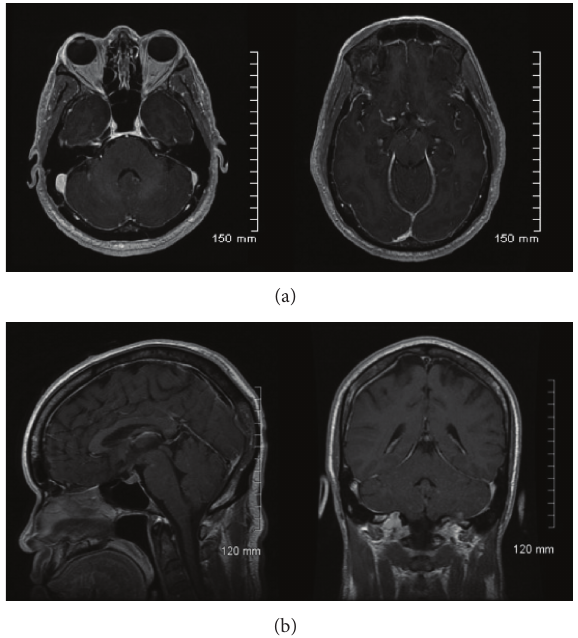
Figure 2: Follow-up MRI: T1 postcontrast axial images on the top row, sagittal and coronal on bottom